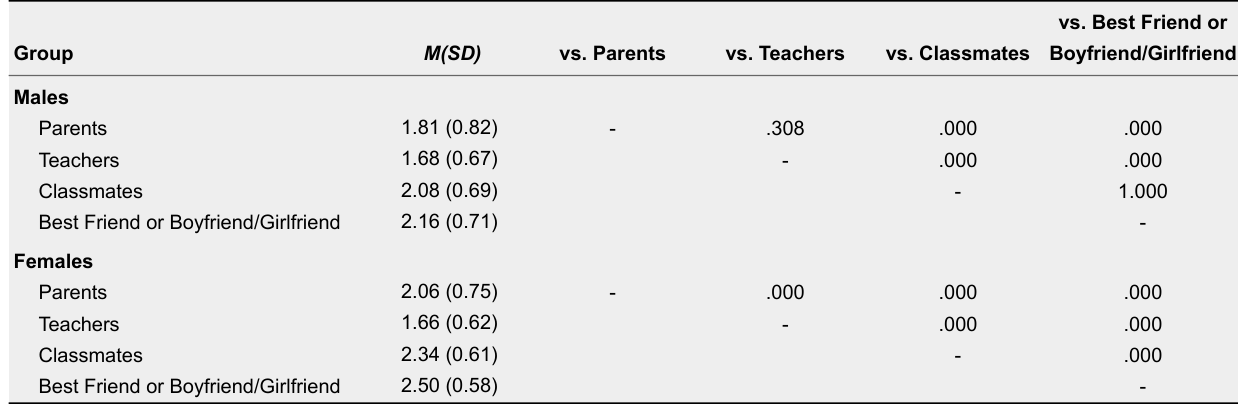
Within-Subjects ANOVAs for Males and Females: Follow-up Comparisons With Bonferronni Correction.